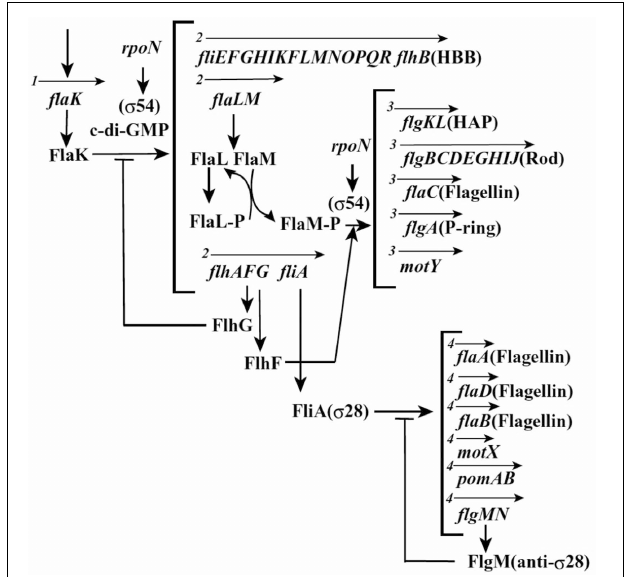
FIGURE 3 | Plausible hierarchy of polar flagellum gene expression in Vibrio , based on previous reports (McCarter, 2001; Correa et al., 2005; Kojima et al., 2011). The arrows indicate the transcription unit and the number at the beginning of arrow indicates the class of transcriptional hierarchy.